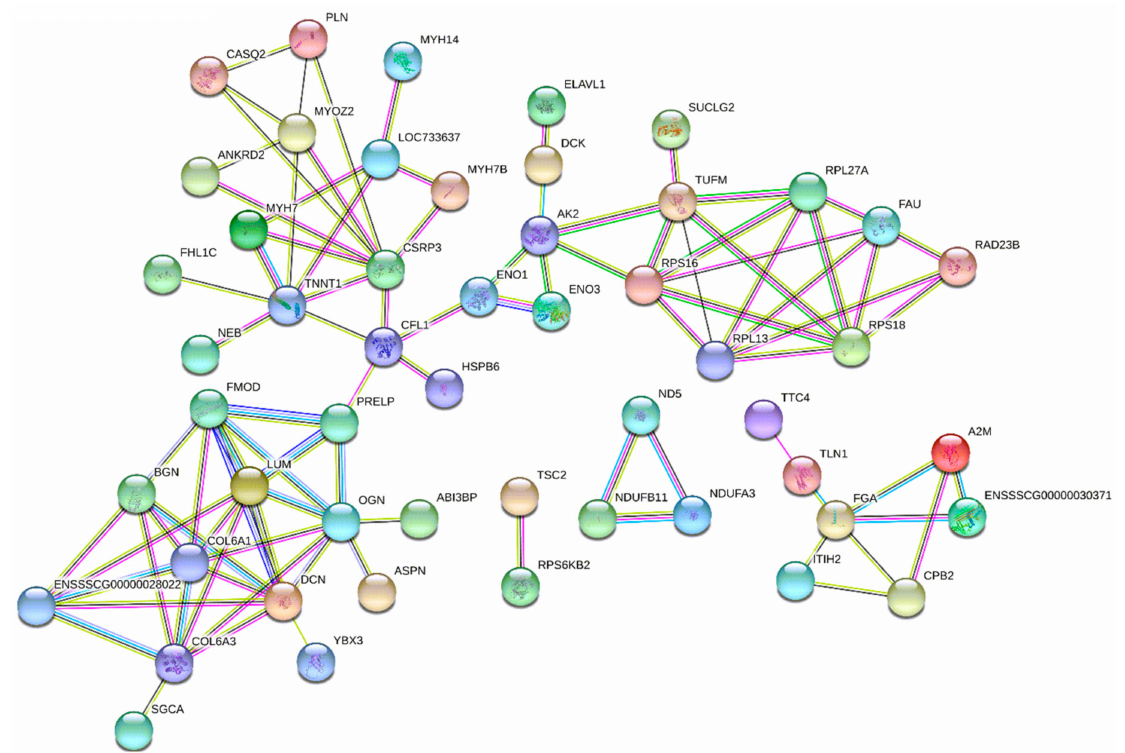
Figure 3. Interaction network of important DEPs (ribosomal proteins, SLRP-type proteoglycans and the collagen proteins and muscle contraction and muscle hypertrophy-related proteins) identified using iTRAQ in pigs fed the fermented diet compared with the control diet. ASPN, asporin; COLA1, collagen type VI alpha 2 chain; COL6A2, collagen type VI alpha 2 chain; COLA3, collagen type VI alpha 3 chain; CSRP3, cysteine and glycine-rich protein 3; DCN, decorin; DEPs, di ff erentially expressed proteins; FMOD, fibromodulin; LUM, lumican; MYH7B, myosin heavy chain 7B; MYH7, myosin-7; OGN, osteoglycin; PRELP, proline and arginine rich end leucine rich repeat protein; RPS18, 40S ribosomal protein S18; RPL27A, 60S ribosomal protein L27a; RPL13, 60S ribosomal protein L13; FAU,40S ribosomal protein S30; RPS16, 40S ribosomal protein S16; TUFM, elongation factor Tu. Network nodes represent proteins; empty nodes : proteins of unknown three-dimensional structure; filled nodes : some three-dimensional structure is known or predicted; colored nodes: query proteins and first shell of interactors. Edges represent protein-protein associations; known Interactions: from curated databases and experimentally determined; predicted interactions: gene neighborhood, gene fusions and gene co-occurrence. Others: text mining, co-expression and protein